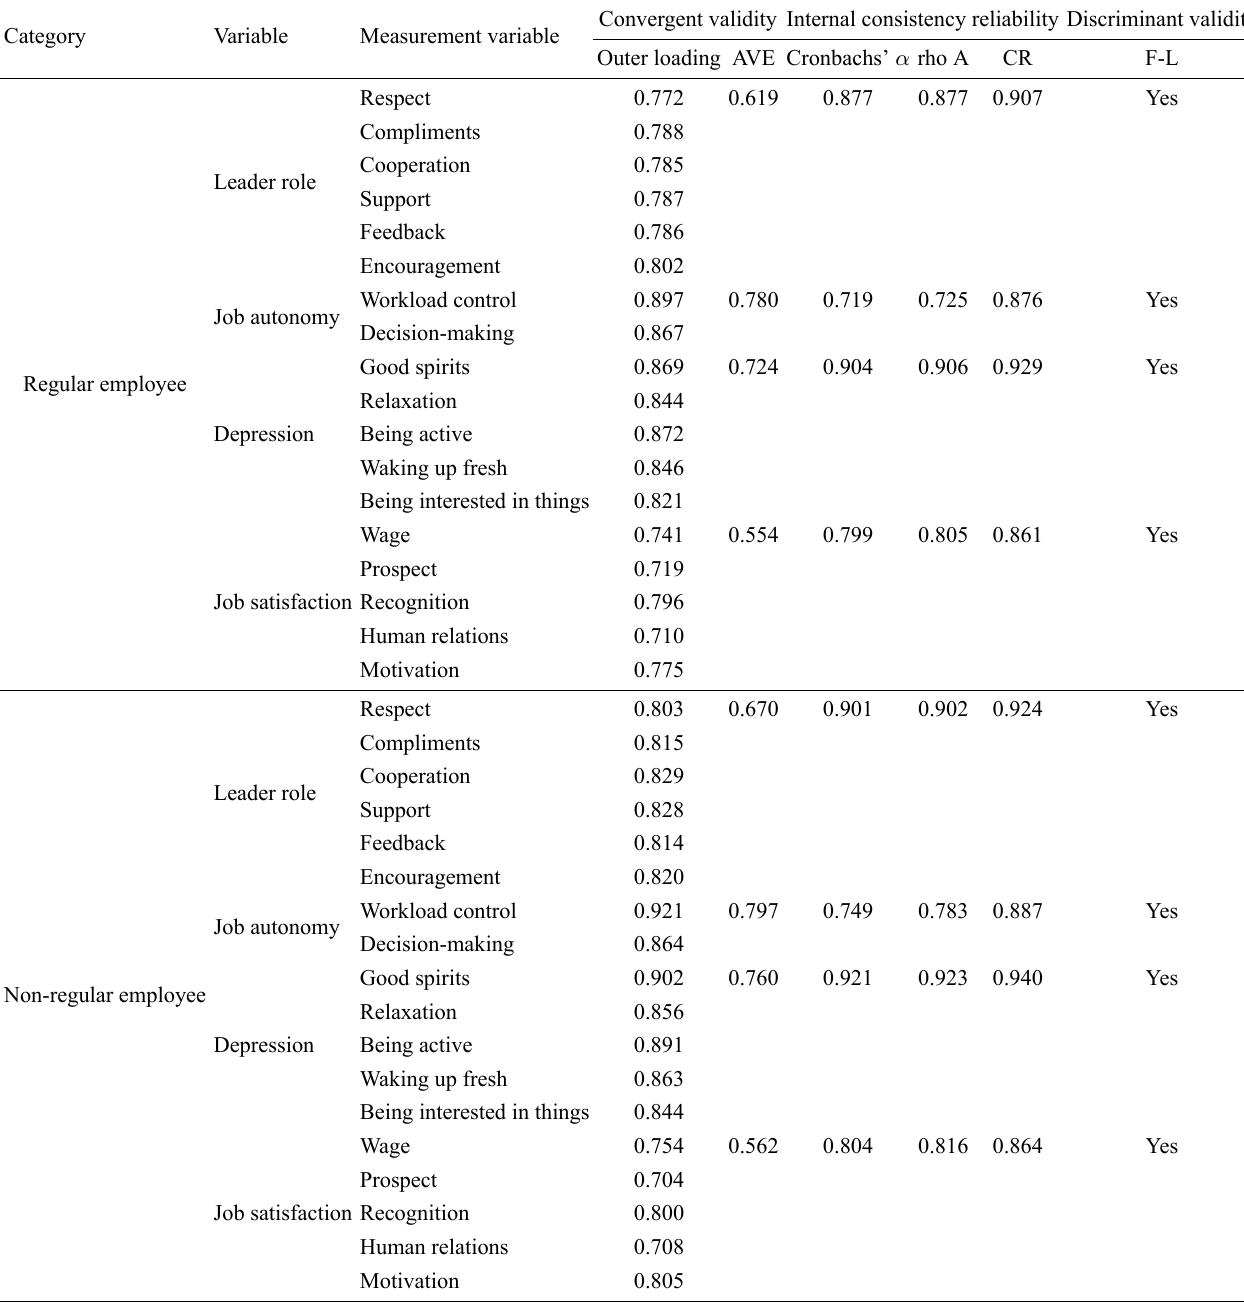
Table 2. Convergent validity, internal consistency reliability, and discriminant validity by